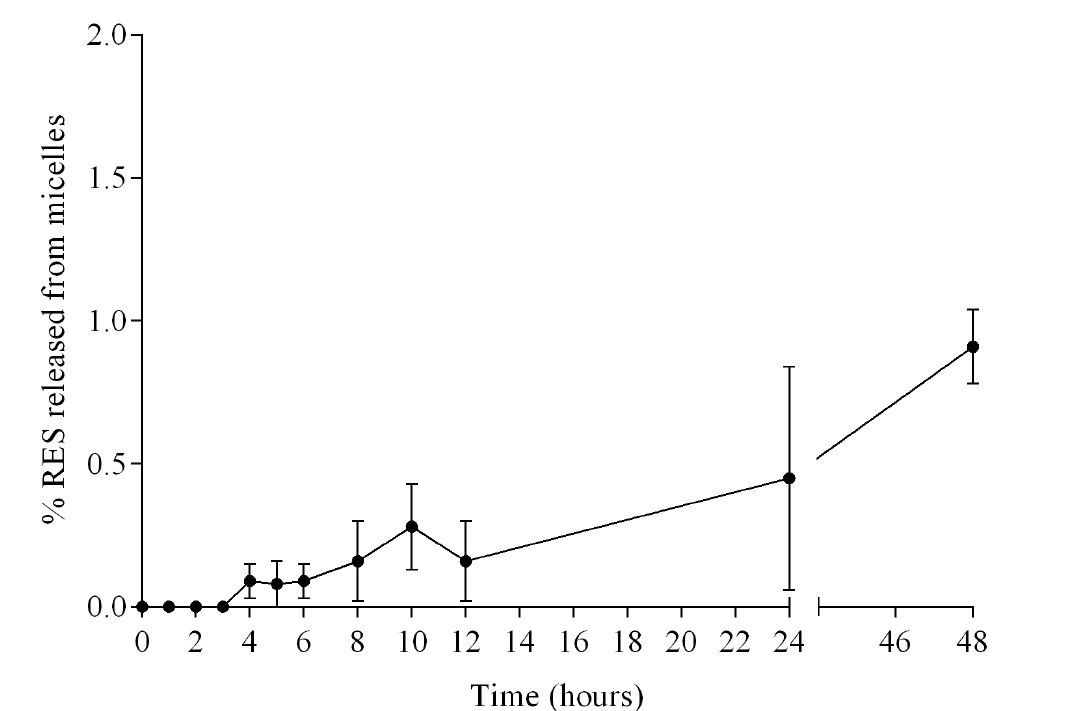
FIGURE 3 - Release of resveratrol from MS-10+RES-3 formulation. Each point represents the mean values ± standard deviation obtained from three experiments.